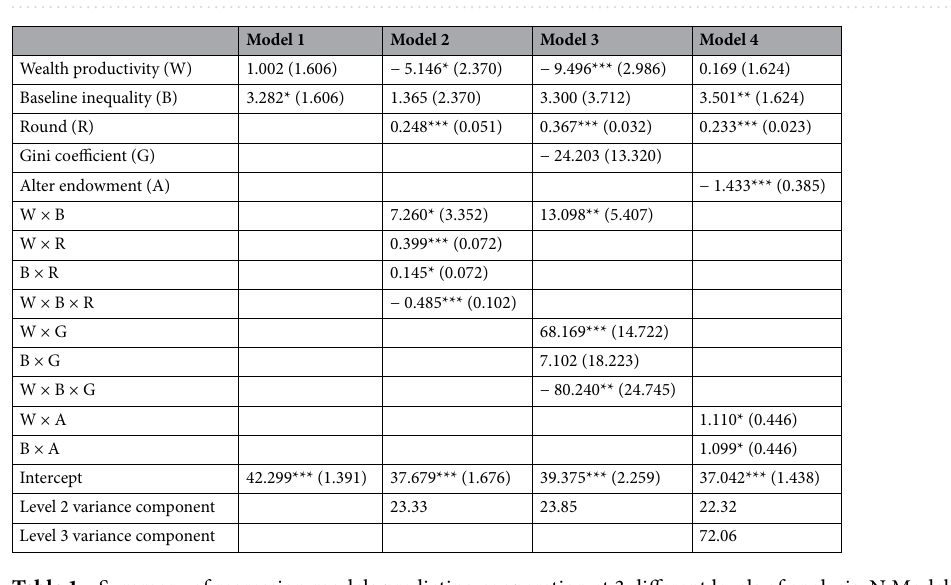
Table 1. Summary of regression models predicting cooperation at 3 different levels of analysis. N Model 1 = 40 networks, N Models 2 and 3 = 520 network-rounds. N Model 4 = 10,185 network-participant-rounds. * p < 0.05, ** p < 0.01, *** p <